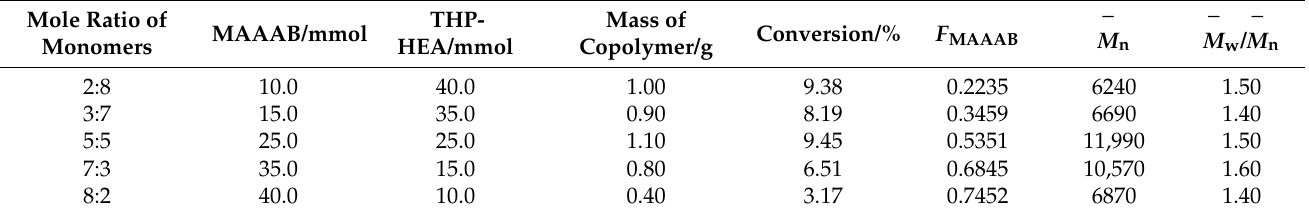
Table 1. Synthetic data and GPC results of PMAAAB- ran